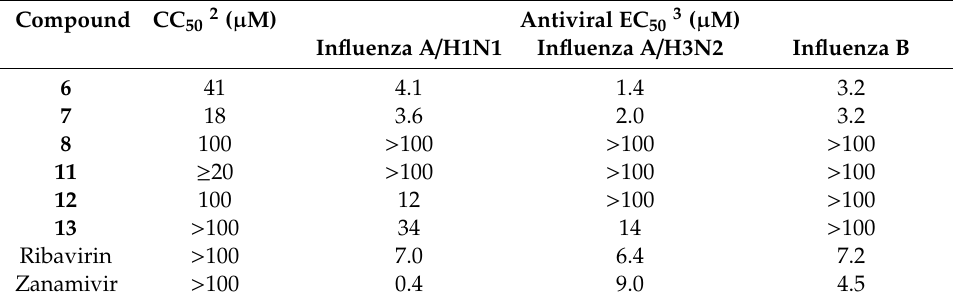
Table 2. Anti-influenza virus activity and cytotoxicity in MDCK 1